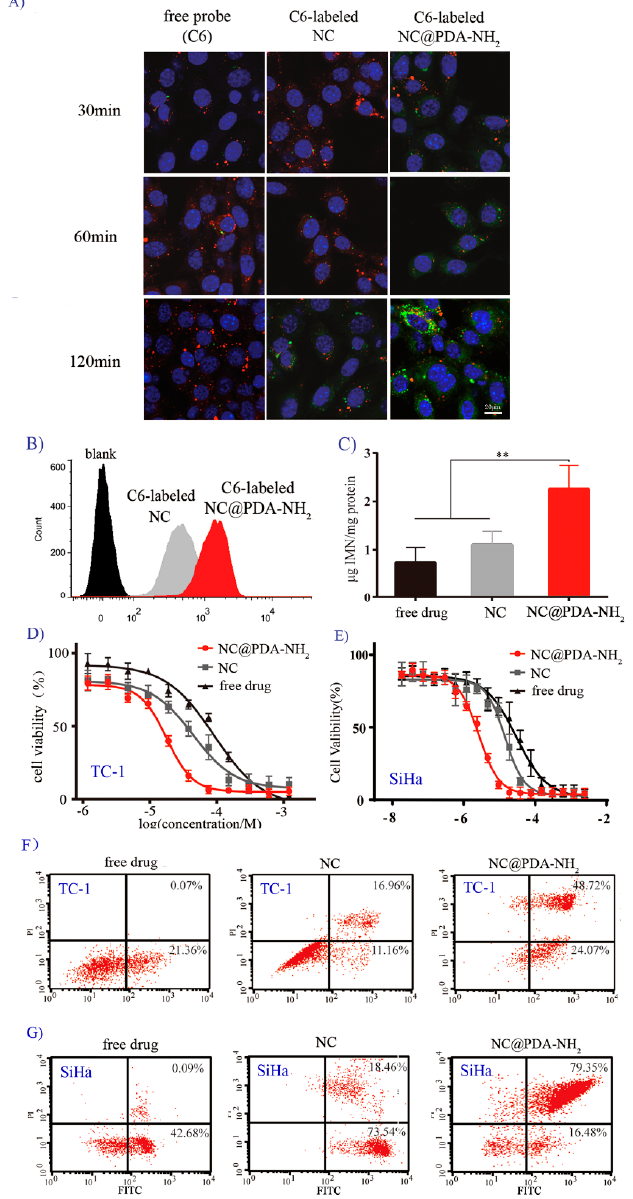
Figure 3. Cellular uptake and cytotoxicity in cervical cancer-related cell lines. ( A ) Representative CLSM images of TC-1 cells co-incubated with 6-coumarin (C6)-labeled NC@PDA-NH 2 , NC, or free probe C6 (green signal). The nucleus was stained with 2-(4-amidinophenyl)-6-indolecarbamindine dihydrochloride (DAPI; blue) and the lysosomes were stained with LysoTracker Red. ( B ) Flow cytometry analysis on the fluorescent intensity of cells after co-incubation for 2 h with C6-labeled NC@PDA-NH 2 , NC, or free probe in TC-1 cells. ( C ) Intracellular drug content after co-incubation